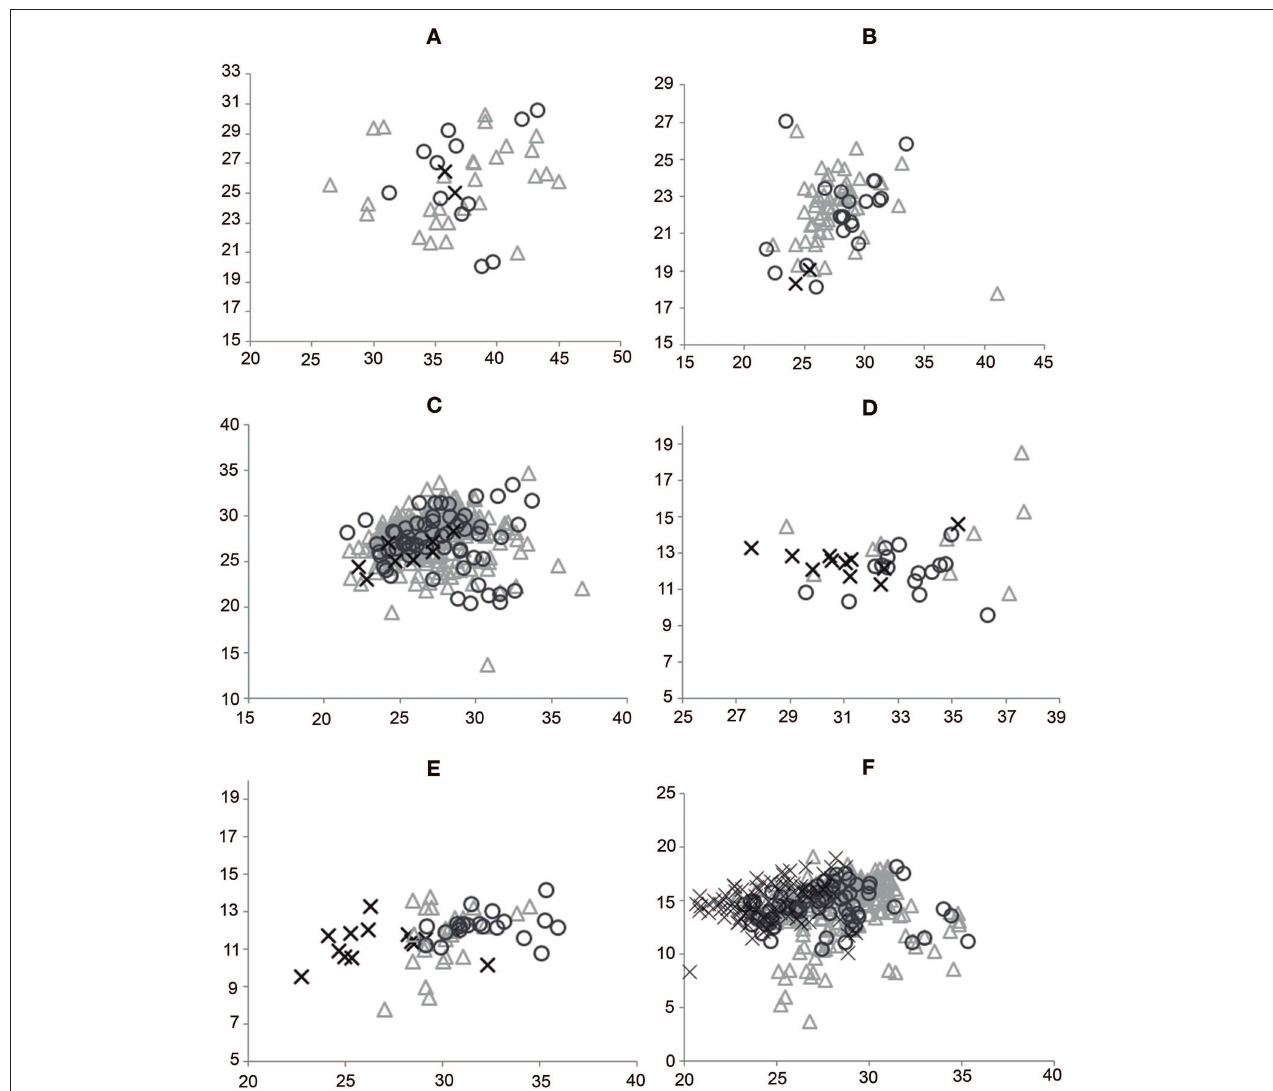
FIGURE 3 | Bivariate analysis of dimensions 2 vs. 4 of P2 (A) , M3 (B) , and P3, P4, M1, and M2 (C) , and dimensions 2 vs. 6 of p2 (D) , m3 (E) , and p3, p4, m1, and m2 (F) for E. neogeus (circle), E. insulatus (triangle), and E. andium (x).